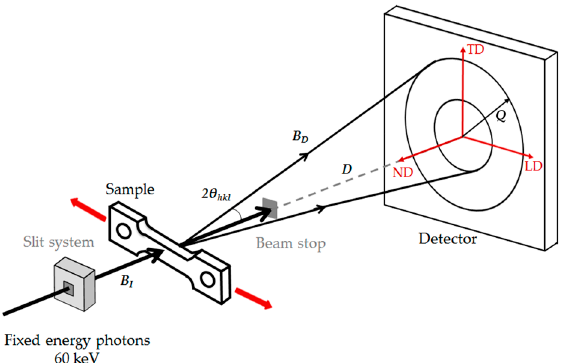
Figure 2. Schematic illustration of the setup of the in situ tensile test tracked by SYXRD. B I and B D are the incident and diffracted beams, respectively; D is the detector distance between the tensile sample and the fast area detector; 2 θ hkl is the angle between the incident and diffracted beams; Q is the scattering vector; LD is the loading direction, TD is the transverse direction and ND is the normal direction.